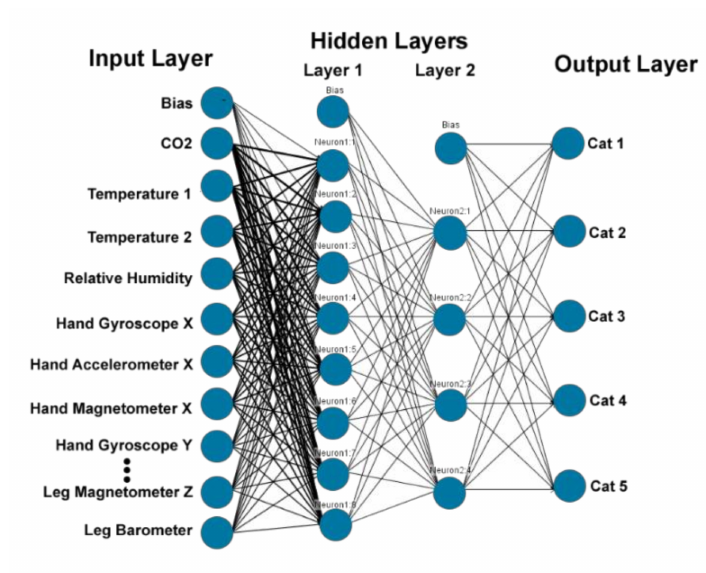
Figure 5. Example of the developed multilayer perceptron artificial neural network model with 24 neurons input layer, eight neurons in the first hidden layer, four neurons in the second hidden layer, five neurons output